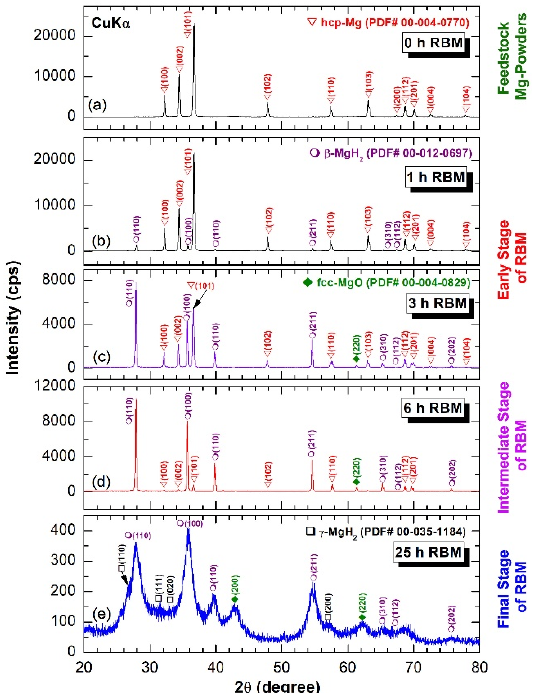
Figure 1. X-ray diffraction (XRD) pattern of as received hcp Mg powder is displayed in ( a ), where the XRD patterns of the powders obtained after reactive ball milling (RBM) for 1, 3, 6 and 25 h are presented in ( b ), ( c ), ( d ) and ( e ), respectively.